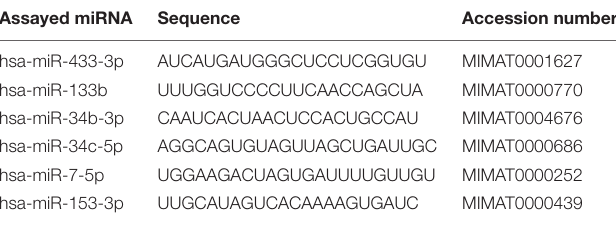
TABLE 1 | The miRNA sequences and miRBase accession